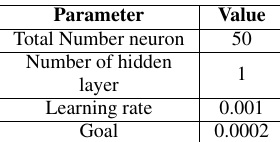
TABLE 4. Training Data (Taguchi-RBF Neural